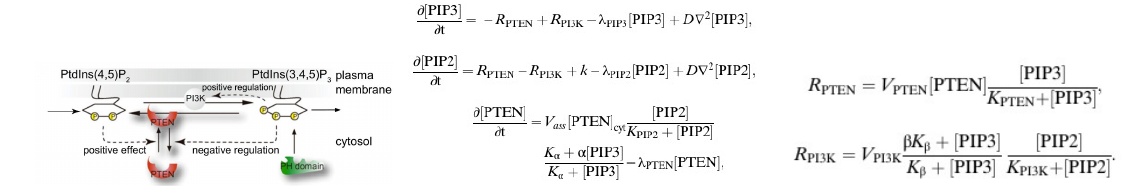
Figure 9. The model of the PIP2-PIP3 reaction and the governing equations. From Arai et al. [73].